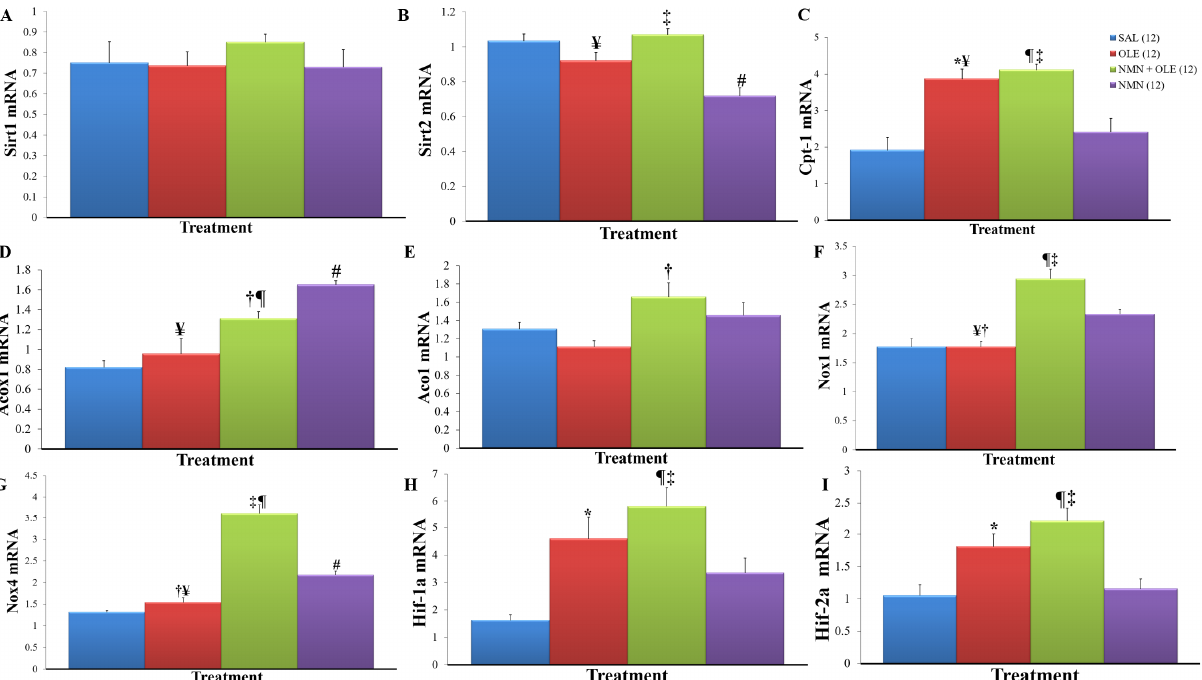
Figure 5. Hepatic mRNA levels after 48 h infusion. Liver lysates ( n ≥ 6 mice/treatment) underwent qPCR analysis of mRNA in replicate and normalized against 18S. ( A ) Sirt1 mRNA levels ( B ) Sirt2 mRNA levels ( C ) Cpt-1 mRNA levels ( D ) Acox1 mRNA levels ( E ) Aco1 mRNA levels ( F ) Nox1 mRNA levels ( G ) Nox4 mRNA levels ( H ) Hif-1a mRNA levels ( I ) Hif-2a mRNA levels. Data are means ± SE. Number in parentheses represents number of animals. * p < 0.05, SAL vs. OLE; ¶ p < 0.05, SAL vs. NMN + OLE; # p < 0.05, SAL vs. NMN; † p < 0.05, OLE vs. NMN + OLE; ‡ p < 0.05, NMN + OLE vs. NMN; ¥ p < 0.05, OLE vs.